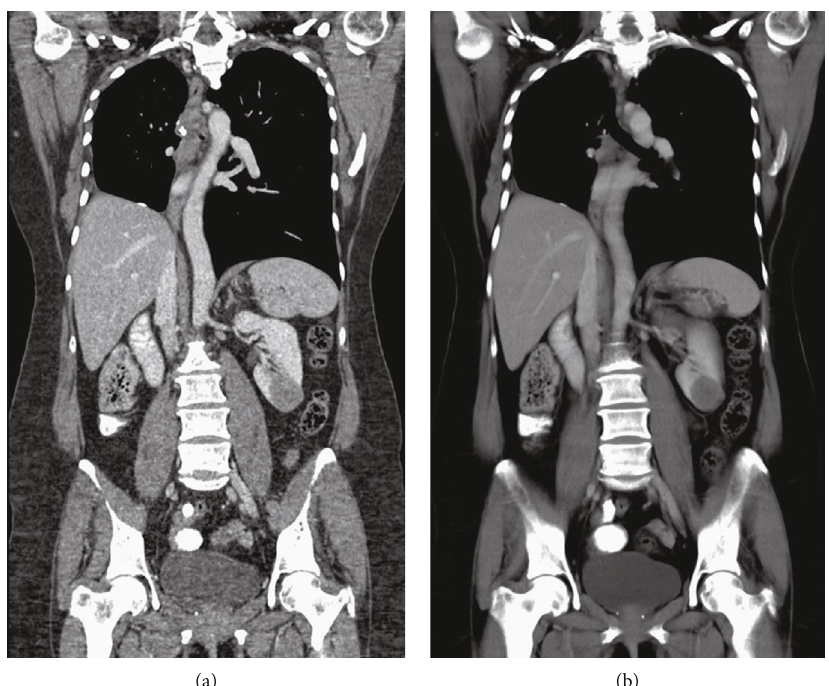
Figure 1: Contrast-enhanced computed tomography in arterial (a) and venous (b) phases, revealing a slightly enhancing mass occupying the lower pole of the left